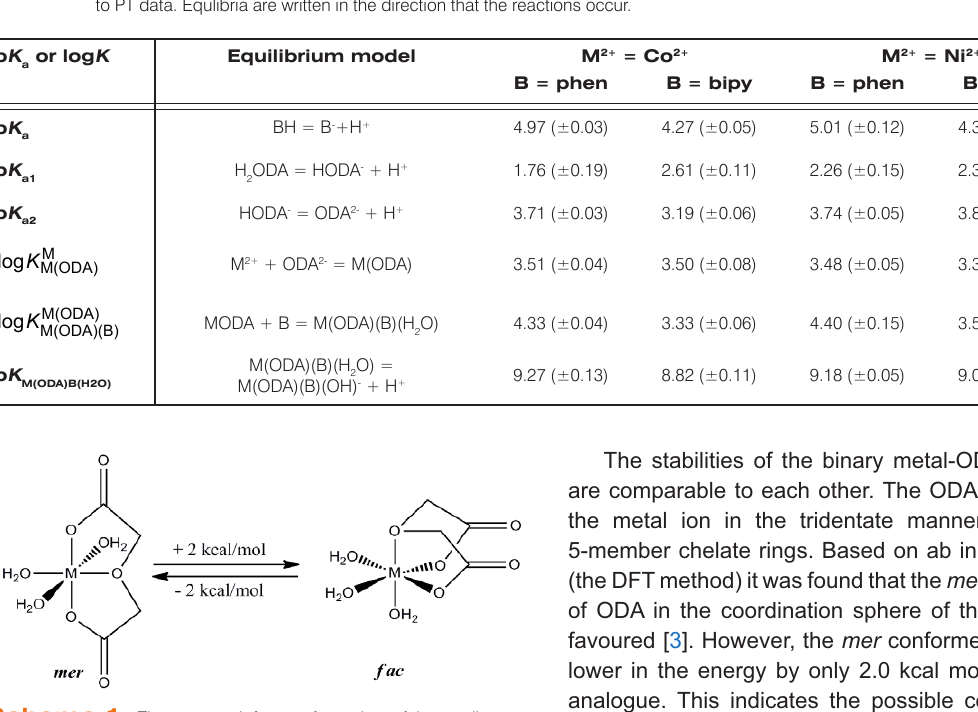
Scheme 1. The mer and fac conformation of the oxydiacetate